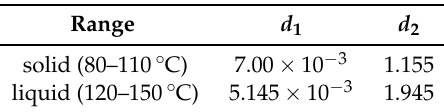
ϑ + d 2 to describe the temperature dependency of ·